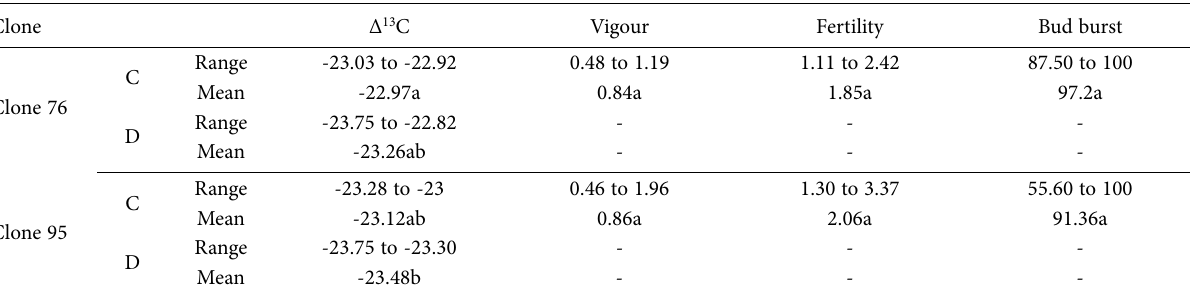
Table 2. Means and ranges of Δ 13 C, vigour, fertility and bud burst parameters obtained for the Chardonnay grapevine clones 76 and 95 from C (control) and D (esca-affected) leaf samples. Bud burst percentage = (number of shoots / number of buds remaining after Chablis pruning) × 100. Fertility = number of clusters/number of shoots. Vine vigour was determined by measurements of cane diameter between the first and second node of the third cane starting from the old part of the trunk (Chablis pruning). Statistically significant differences ( P < 0.05) between clones are indicated by different letters.